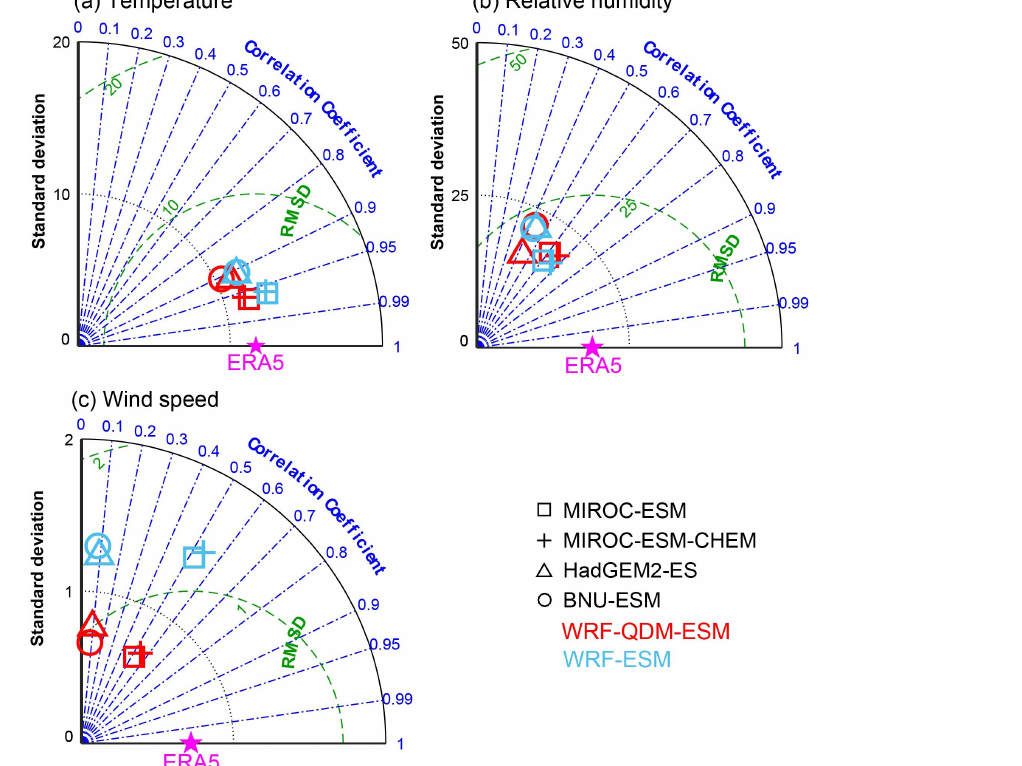
Figure 8. Taylor diagram for daily temperature (a) , relative humidity (b) and wind speed (c) of WRF driven by four ESMs results with QDM bias correction (red) and without bias correction (blue) compared to ERA5 reanalysis data (purple star) during 2008–2017 in